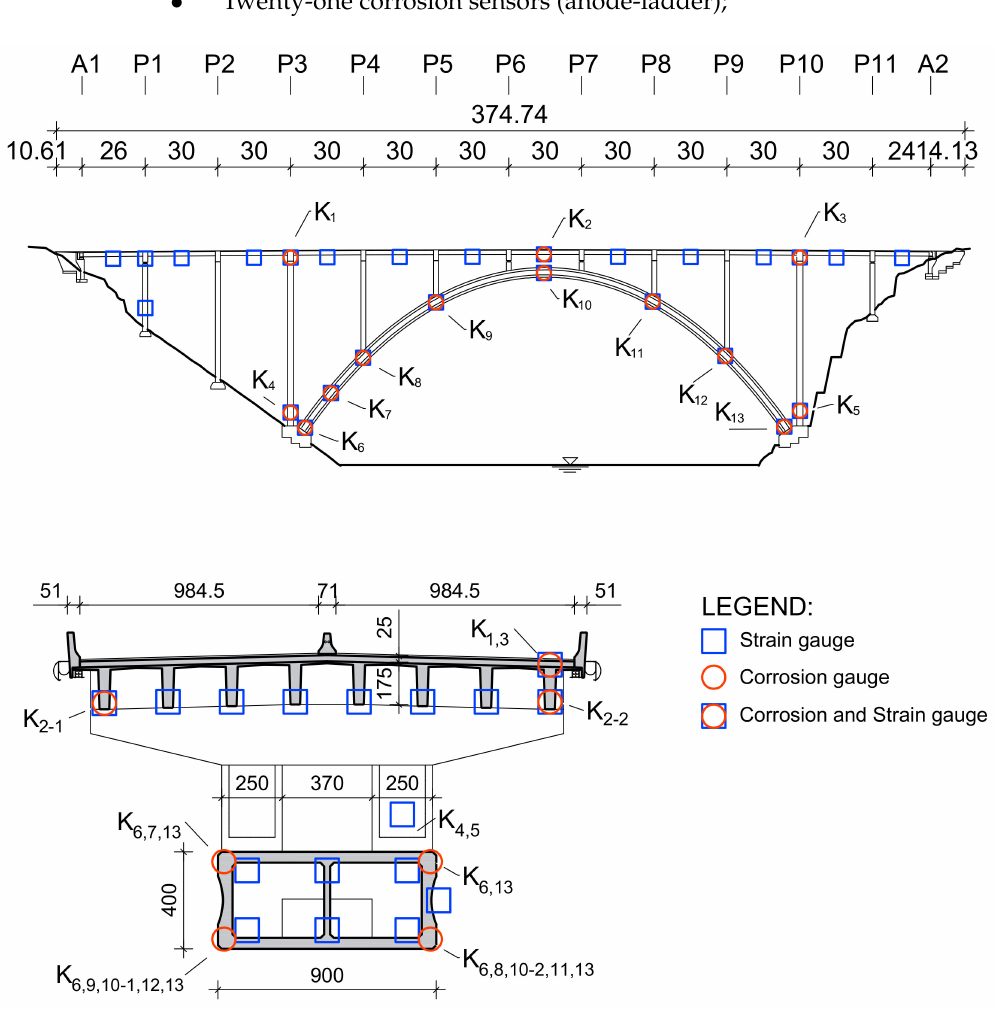
Figure 2. Location of strain and corrosion gauges installed on the Maslenica